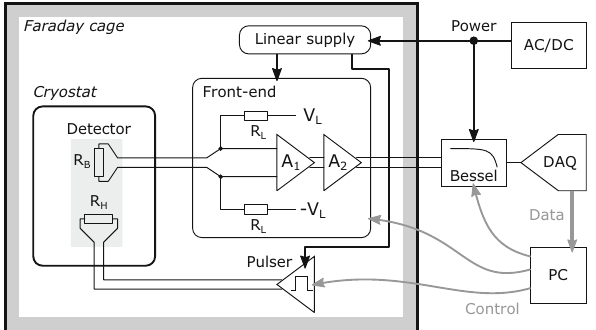
Fig. 19 Block diagram of a readout channel, from the detector to the DAQ